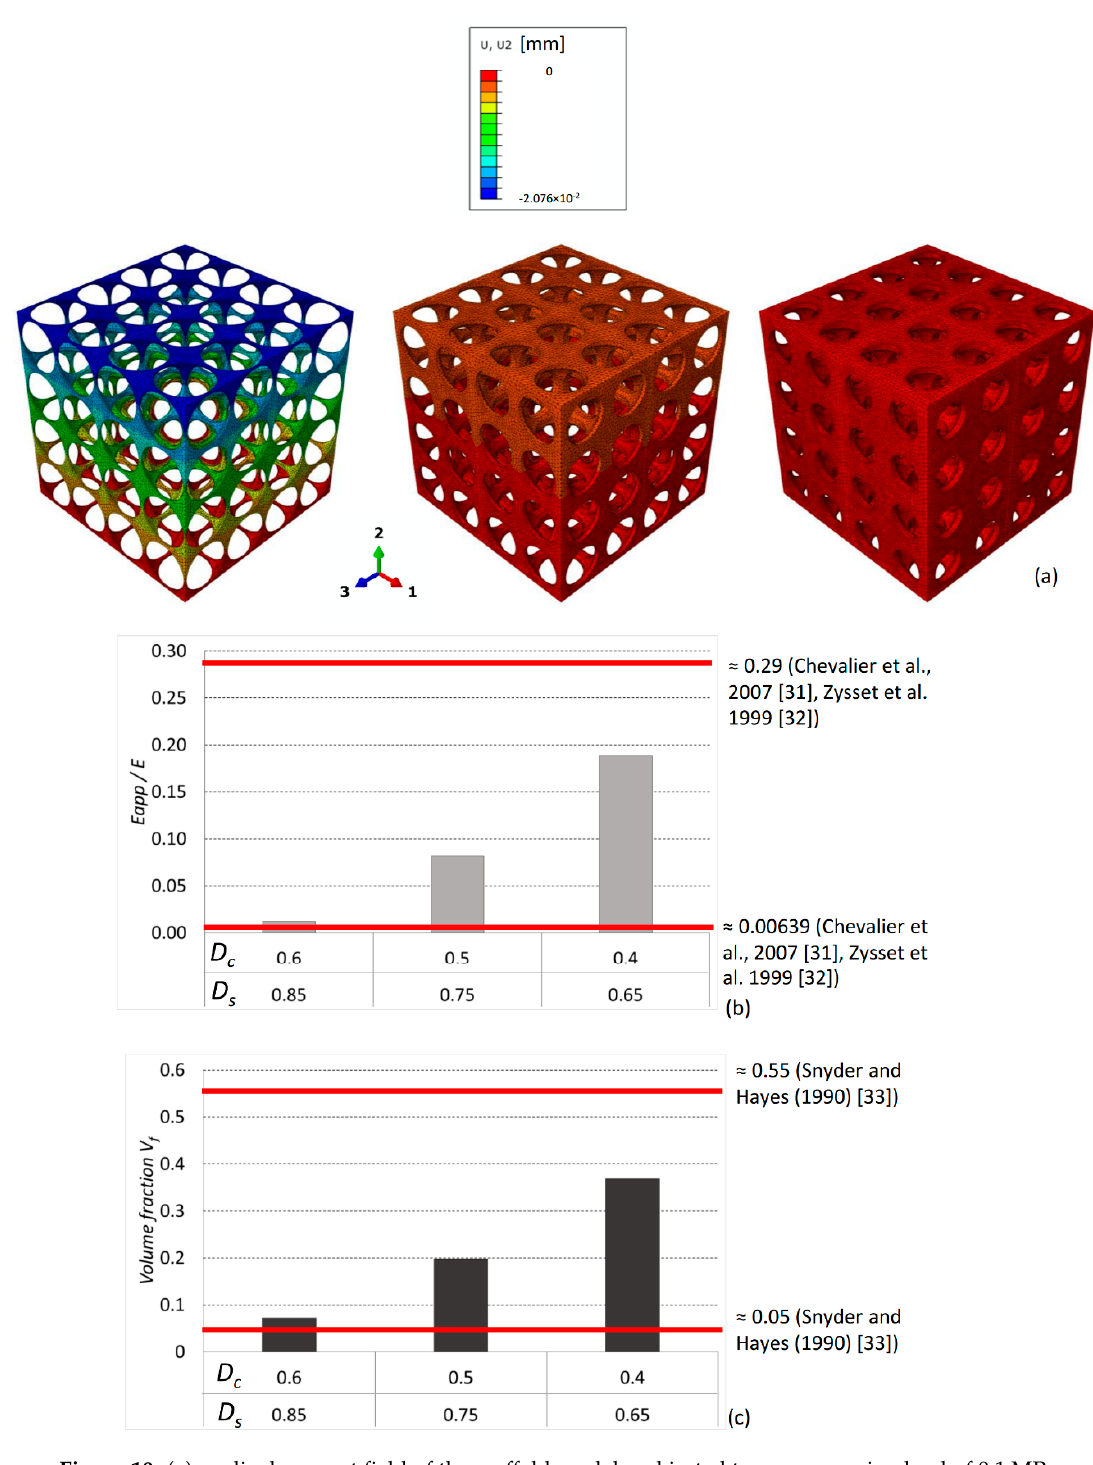
Figure 10. ( a ) u 2 displacement field of the sca ff old models subjected to a compression load of 0.1 MPa. ( b ) Values of the ratio E app / E computed for the three models and compared with those experimentally measured (represented with the red lines) for cancellous bone. ( c ) Sca ff old volume fraction values compared with the volume fraction of human spongy bone. Table 2. Material properties utilized in the model of scaffold and granulation tissue [15,17,18]. Material Property Granulation Tissue Scaffold Young’s modulus [MPa] Poisson’s ratio